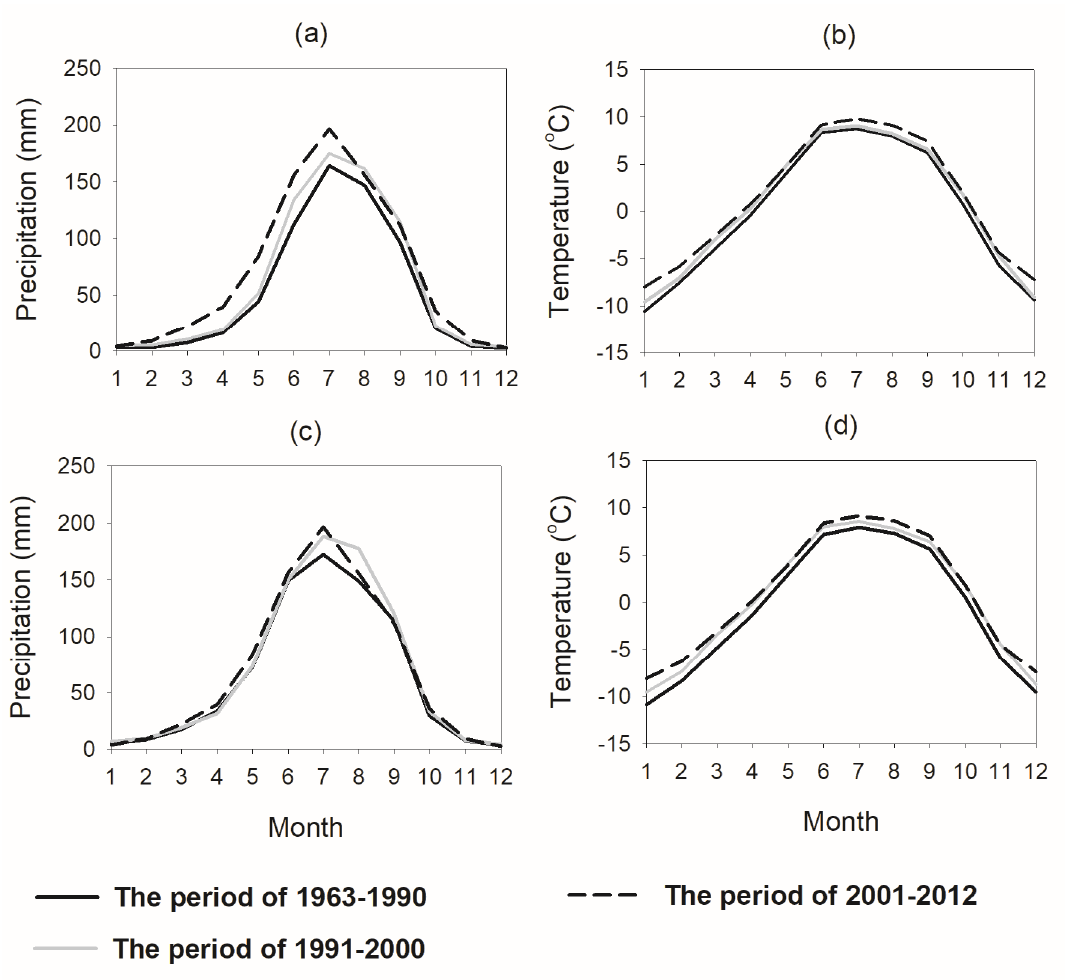
Figure 9. Mean monthly precipitation and temperature in the three periods over the LRB ( a , b ) and UNRB ( c , d ).